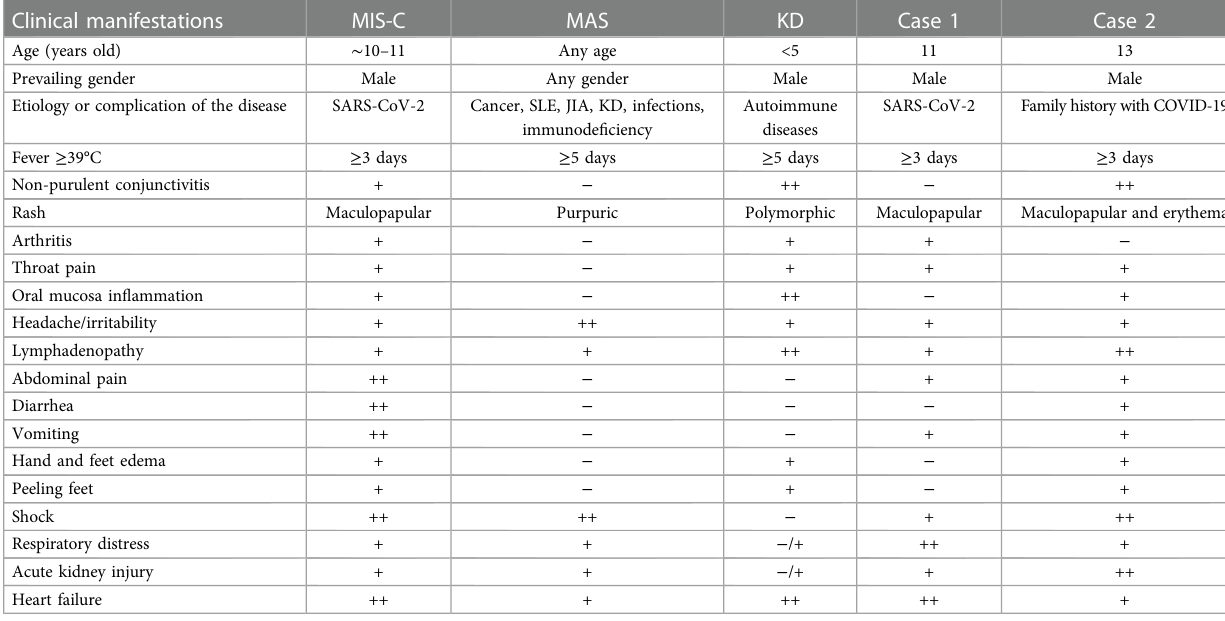
TABLE 1 Comparison of the clinical features of MIS-C, MAS, and KD with the two cases described. Clinical